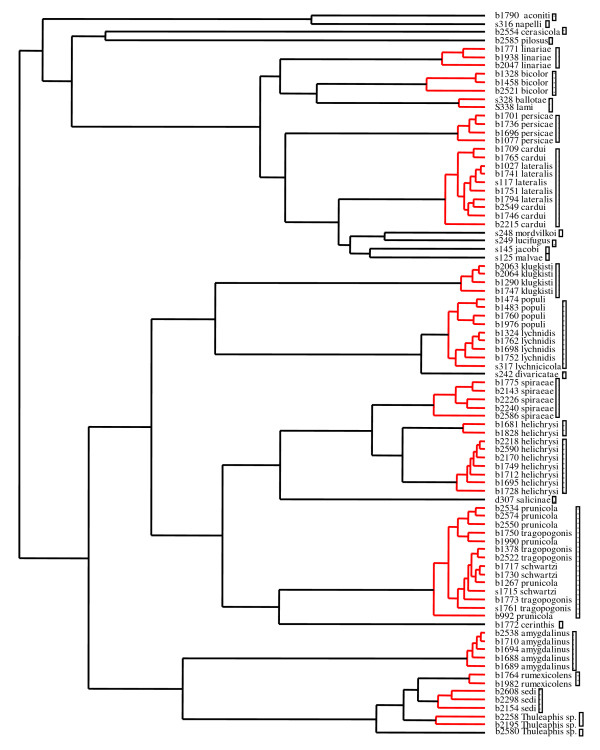
Species delimitation results. The vertical bars group all specimens identified as belonging to a significant cluster.